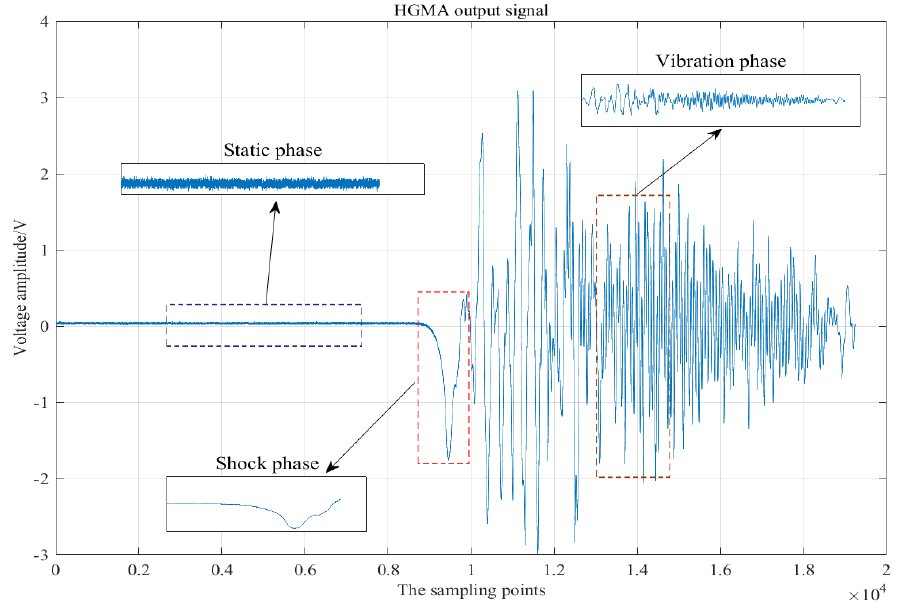
Figure 12. Voltage output signal of HGMA.